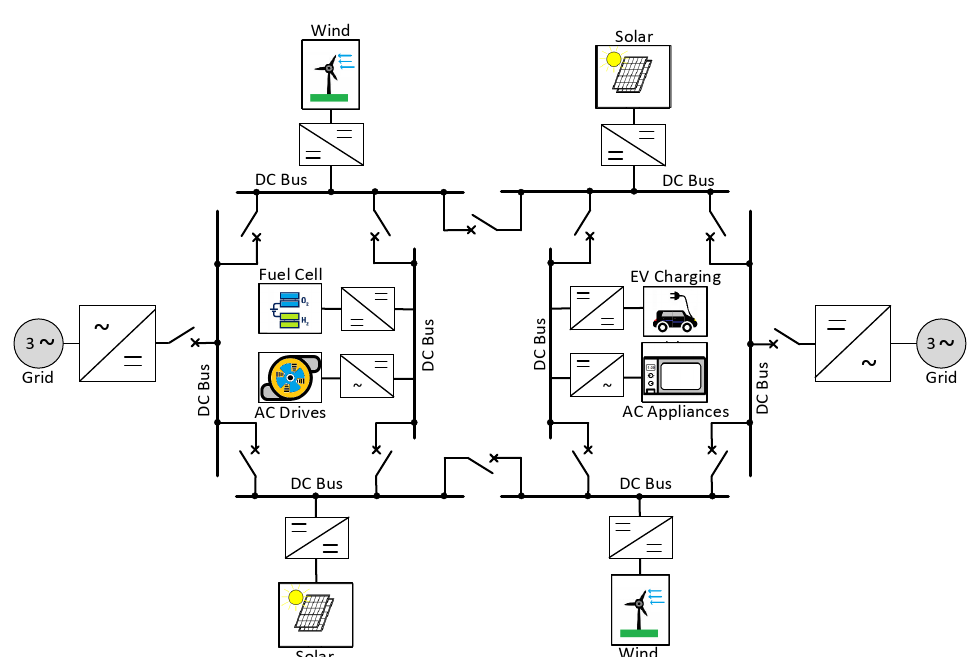
Figure 5. A schematic of typical example of the interconnected topology.